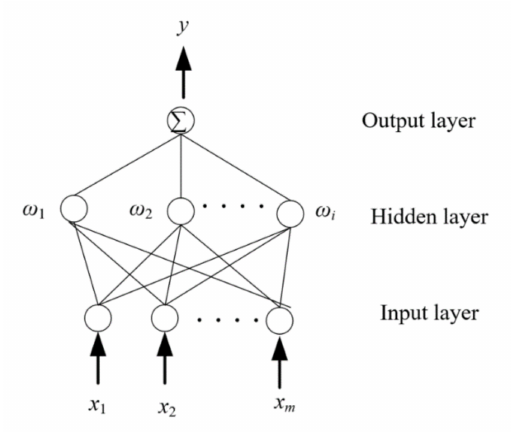
Figure 6. Principle of RBF neural